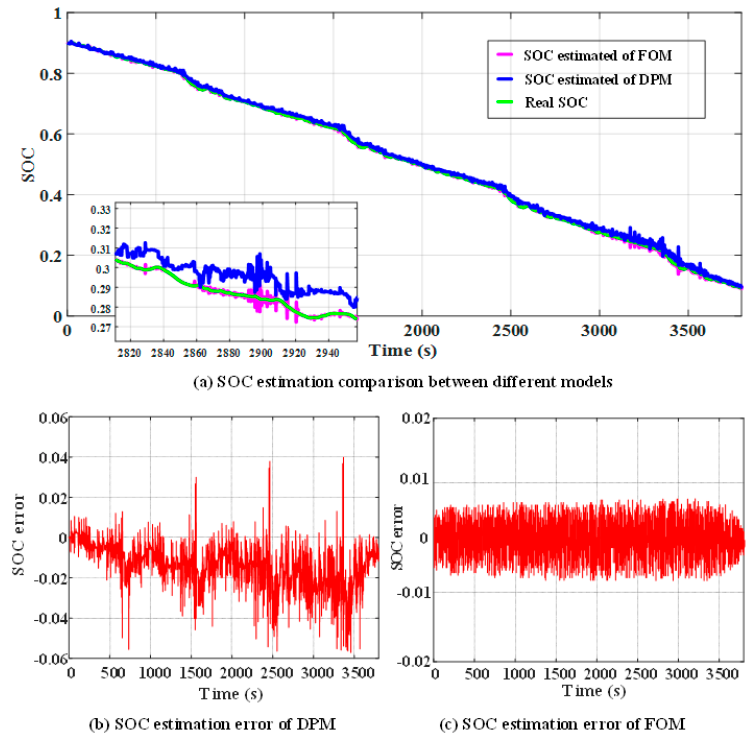
Figure 10. SOC estimation results under the federal urban driving schedule (FUDS) test cycle condition.